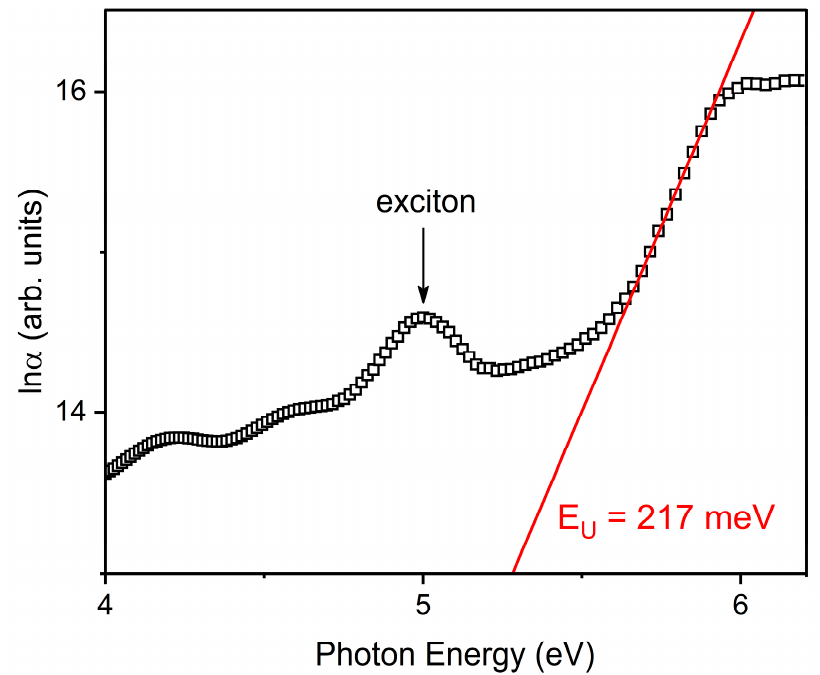
Figure 4. Spectral dependence of the absorption coefficient in the Urbach coordinates of the Y 2 O 3 film. Red line shows an approximation of the linear range of ln α ( hv ) dependence. The Urbach energy E U was derived from Equation (6). The accuracy of E U calculation is ± 2 meV.